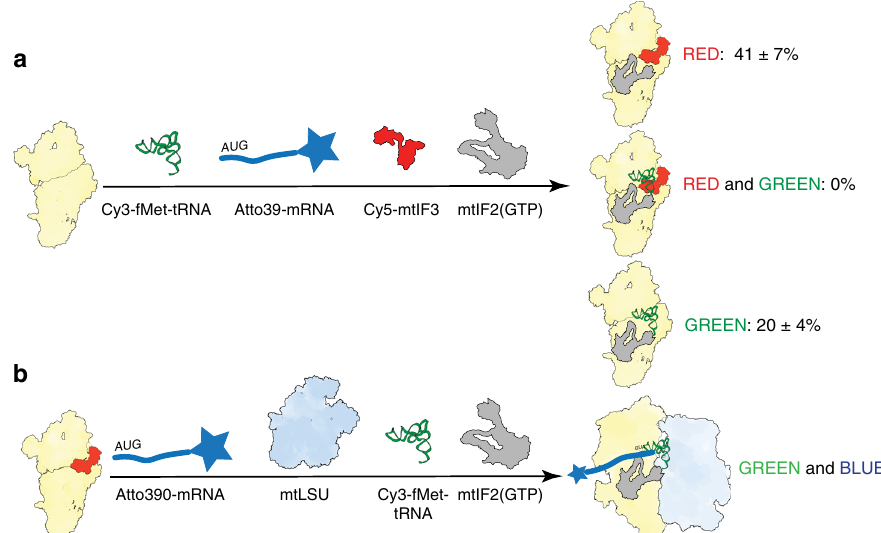
Fig. 3 Binding of mtIF3 and fMet-tRNA fMet i to the mtSSU is mutually exclusive. a Two-color fl uorescence cross-correlation spectroscopy analysis of the initiation complex components. The mtSSU was incubated with an excess of Cy3-fMet-tRNA fMet i , Cy5-mtIF3, mtIF2(GTP), and Atto390-mRNA, then puri fi ed by a sucrose gradient. Products may contain unlabeled mtIF2. b The functionality of mtPIC was validated by the ability to form a complete initiation complex when incubated with an excess of mtLSU, Cy3-fMet-tRNA fMet i , Atto390-mRNA, and unlabeled mtIF2 (GTP). After puri fi cation of the monosome, detection of both Cy3 and Atto390 fl uorophores con fi rmed binding of mRNA and tRNA. Source data are provided as a Source Data fi